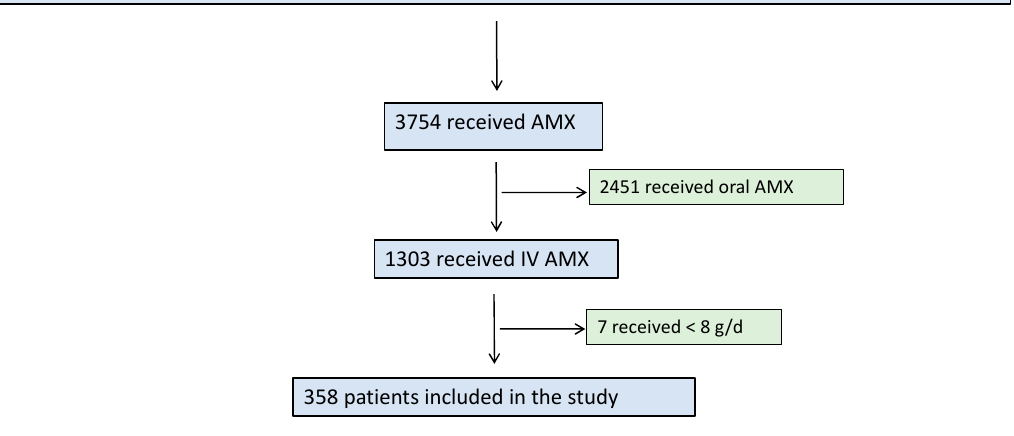
Figure 1. Flowchart of the study.